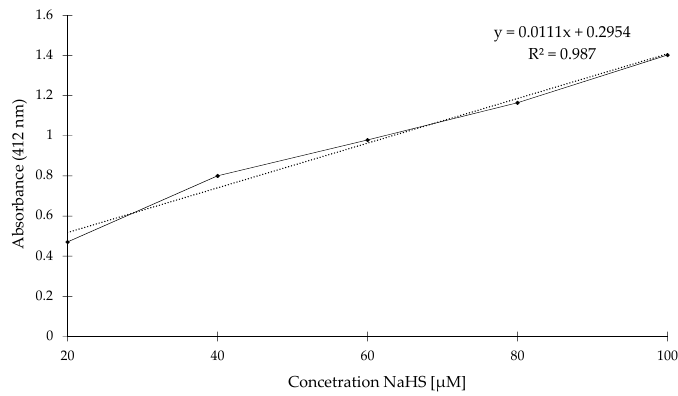
Figure 12. The correlation between absorbance and NaHS concentration determined by the DTNB assay in sodium phosphate buffer (pH 8.0) at room temperature. The absorbance at 412 nm was recorded for 15 min after addition of various concentrations of NaHS from 20 to 100 µ m. Values of absorbance are given as means obtained from 3 measurements. Background values were subtracted from the sample